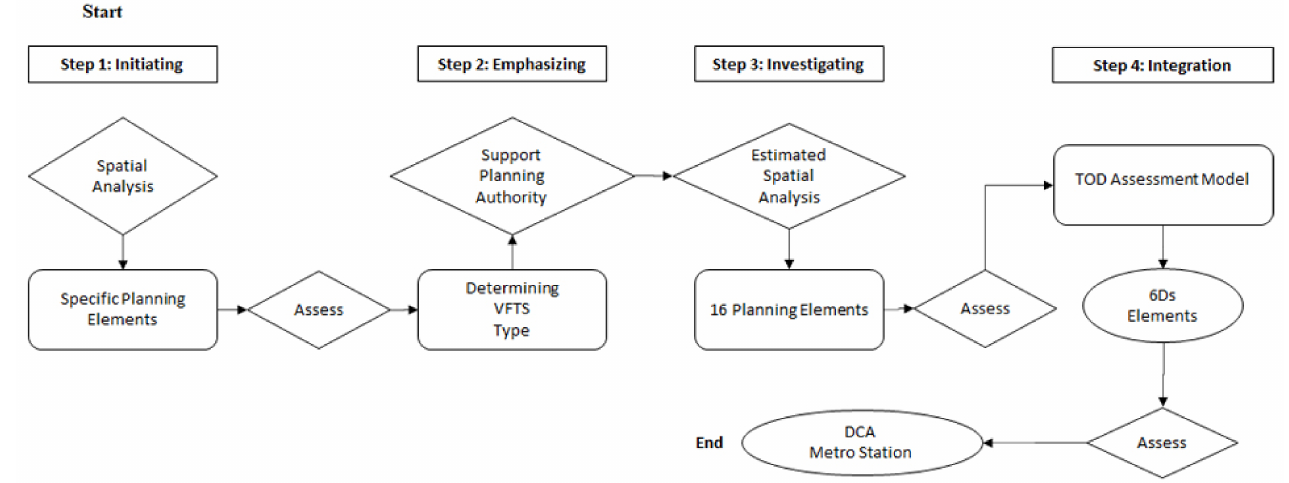
Figure 19. The whole process of the pre-TOD assessment